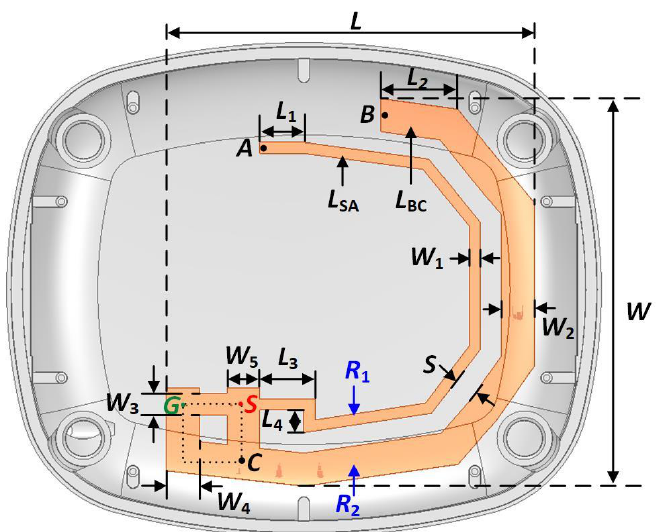
Figure 6. Antenna